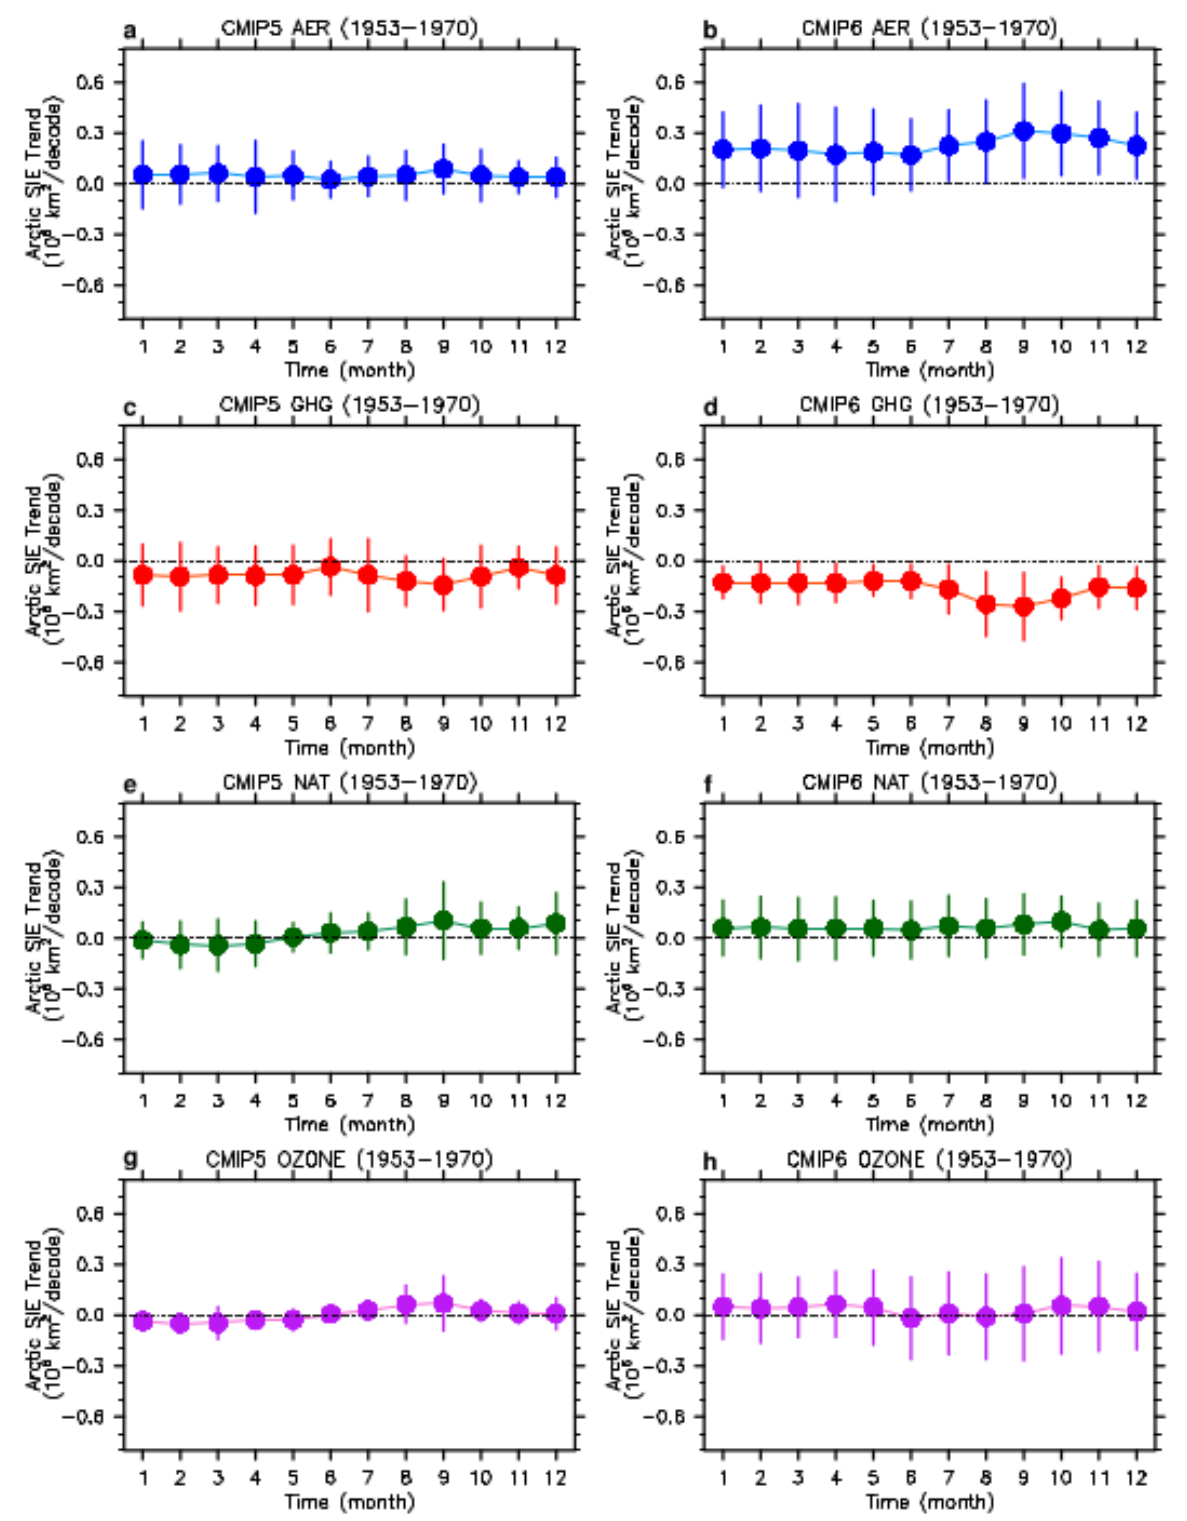
Figure 8. ( a , c , e , g ) Linear trends of monthly mean Arctic sea ice extents from CMIP5 ( a ) AER, ( c ) GHG, ( e ) NAT, and ( g ) OZONE simulations over 1953–1970. Dots indicate MMMs and bars indicate inter-model spreads. ( b , d , f , h ) Same as ( a , c , e , g ) but for